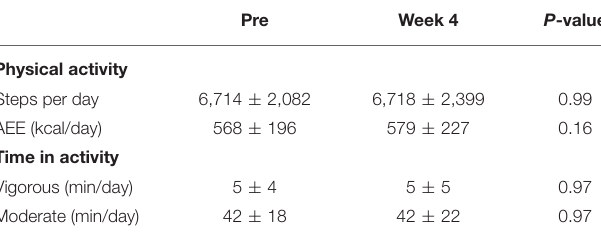
TABLE 3 | Mean physical activity characteristics at baseline and during week 4 (excluding prescribed exercise) of the 4 week exercise intervention ( n = 13). Pre P